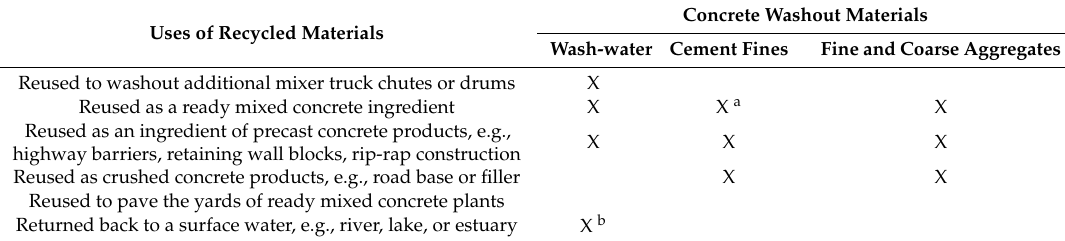
Table 1. Reusing of concrete washout waste materials (after EPA,